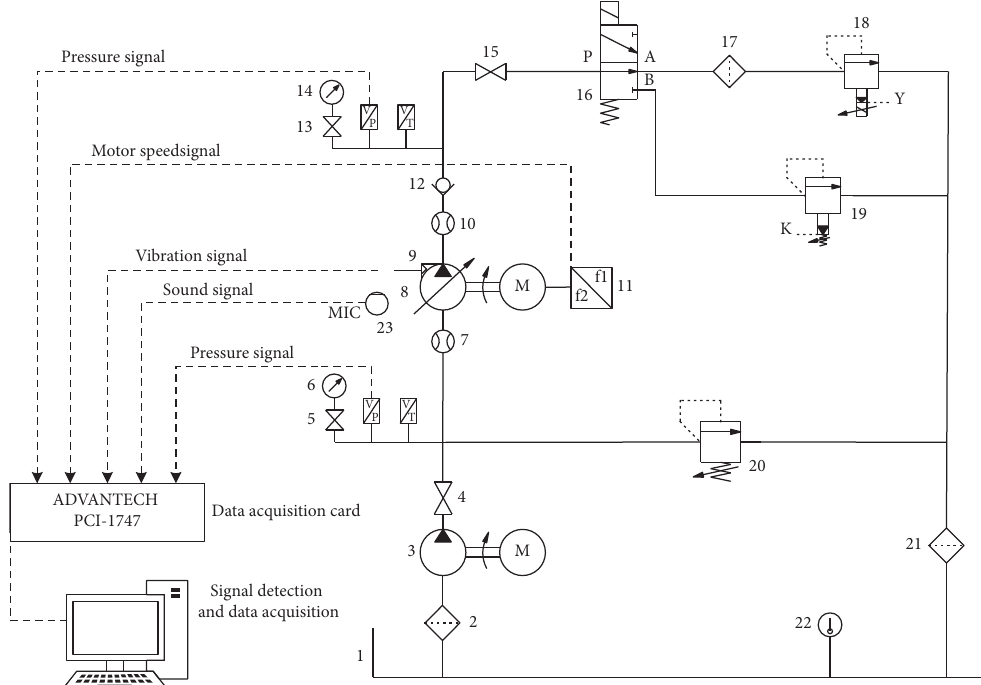
Figure 7: Hydraulic system diagram of hydraulic pump failure simulation test bench.1, oil tank; 2, 21, and 17, filter; 3, vane pump; 4 and 15, stop valve; 5 and 13, pressure gauge switch; 6 and 14, pressure; 7 and 10, flow meter; 8, axial piston; 9, vibration sensor; 11, frequency converter; 12, check valve; 16, two-position three-way solenoid valve; 18, pilot-operated proportional overflow valve; 19, pilot-operated overflow value; 20, overflow value; 22, temperature meter; 23, impulse sound level meter.